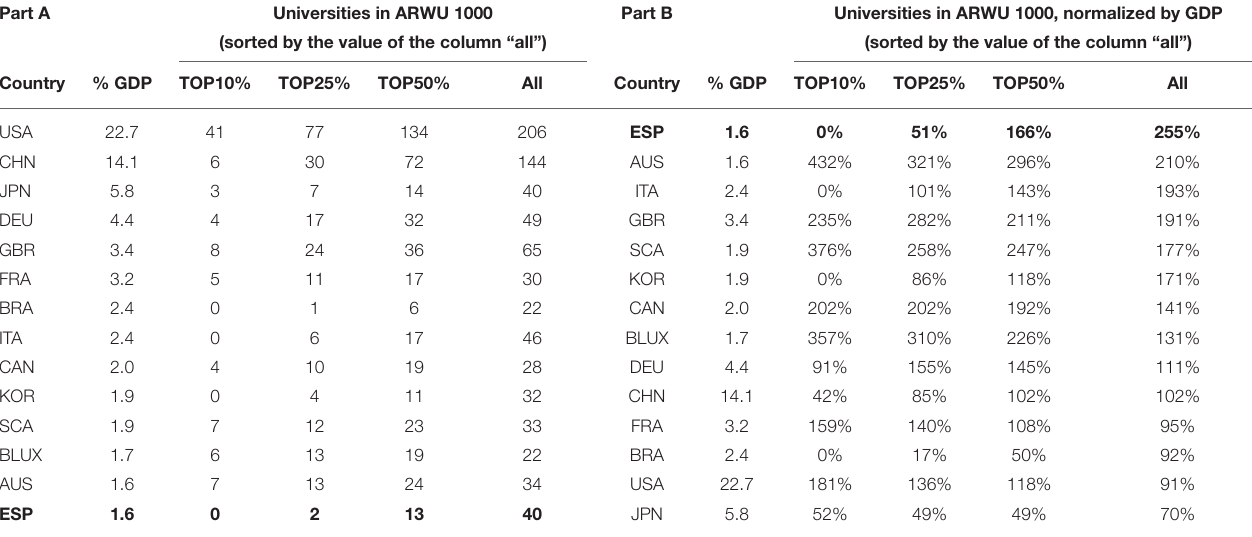
TABLE 5 | Number of universities in ARWU 2020. Part A Universities in ARWU 1000 Part B Universities in ARWU 1000, normalized by GDP (sorted by the value of the column “all”) (sorted by the value of the column “all”)